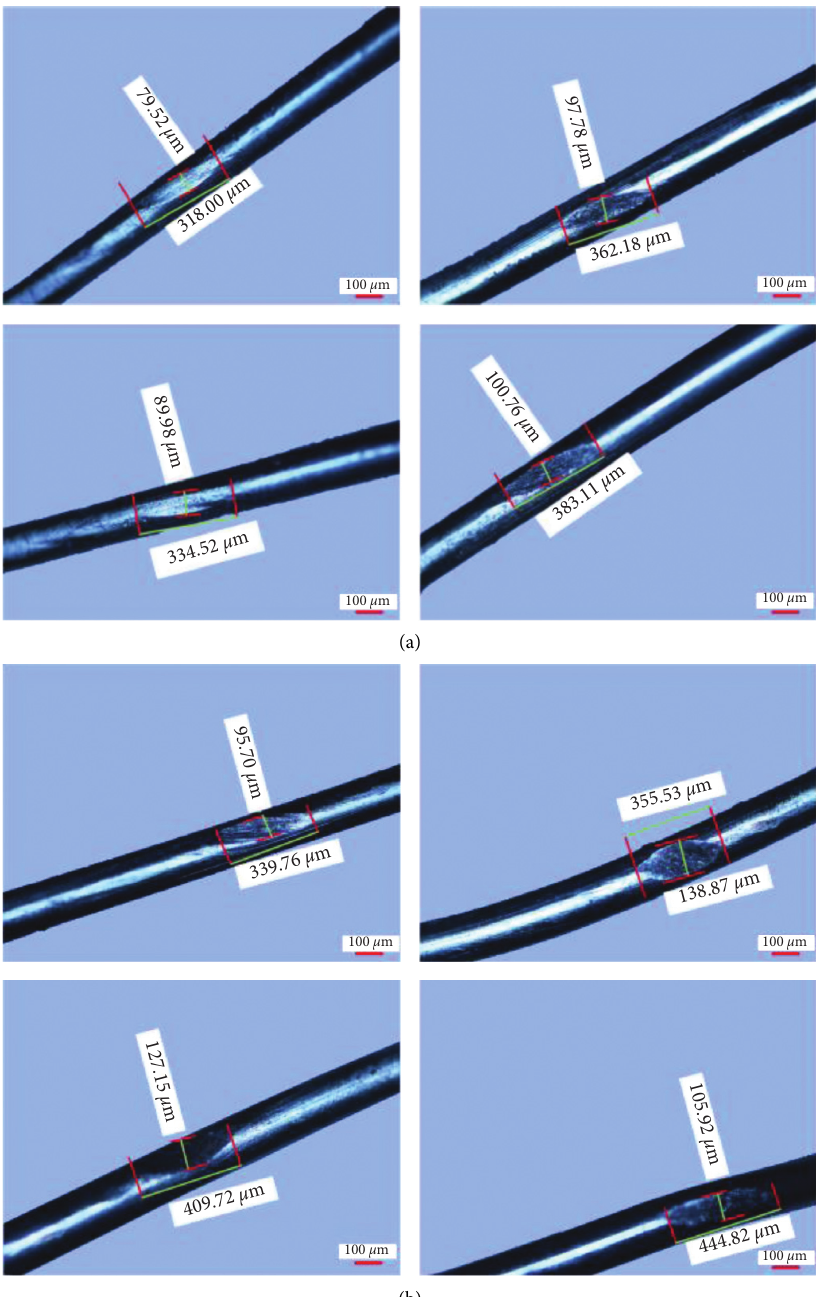
Figure 18: Comparison of surface wear scars of continuous and discontinuous steel wire. (a) Wear scar on the worn surface of steel wire rope in continuous contact. (b) Wear scar on the worn surface of steel wire rope in discontinuous